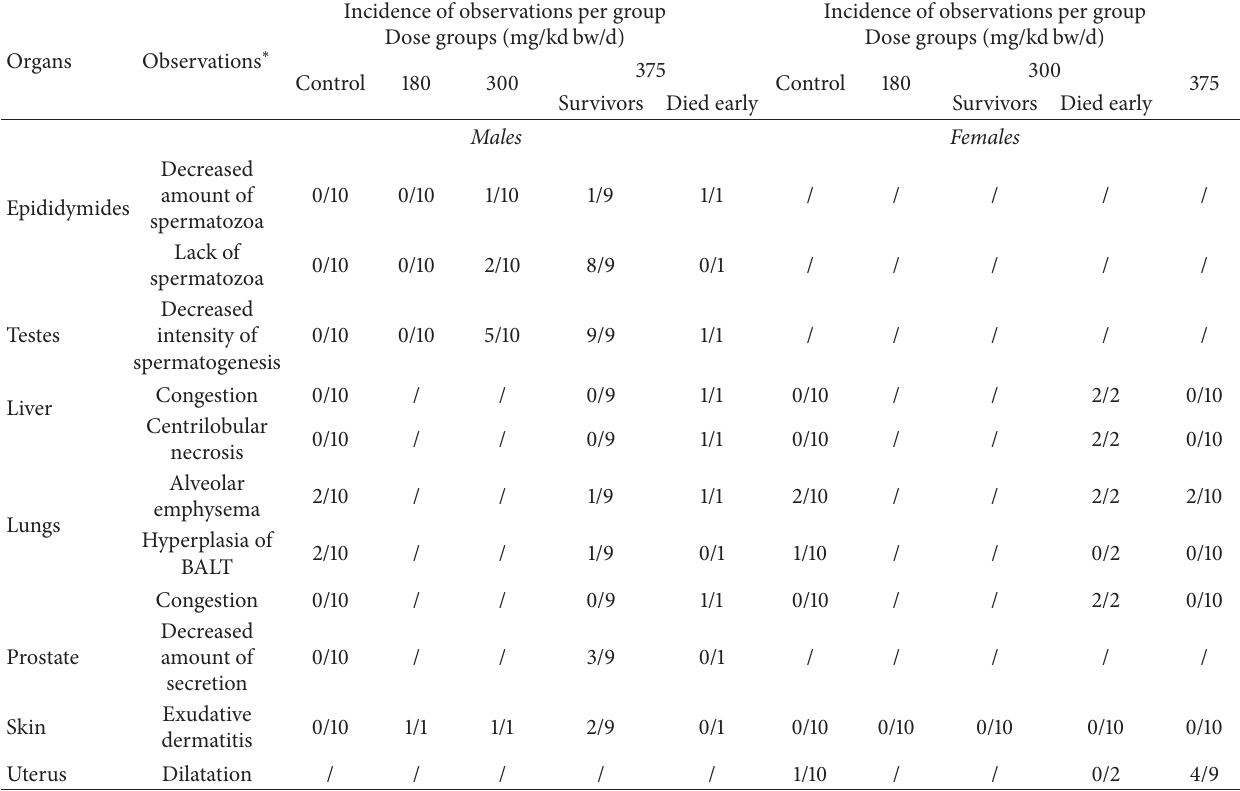
Table 2: Summary of notable histopathology